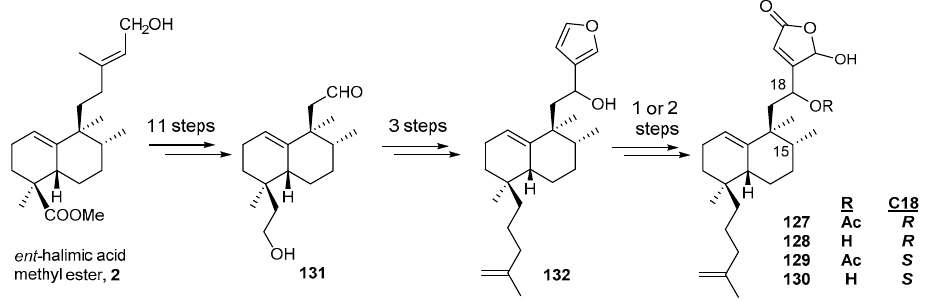
Scheme 5. Synthesis of sesterterpenolides from 2 .